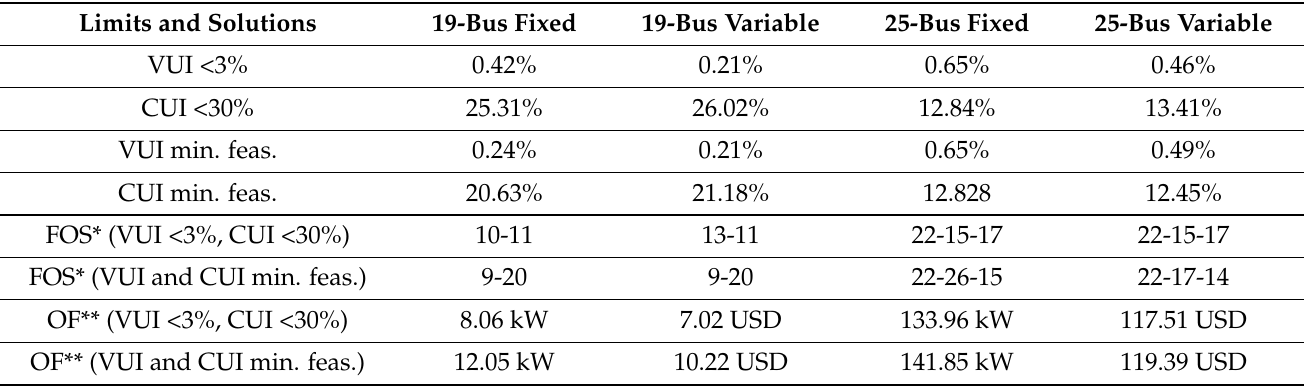
Table 16. VUI and CUI for unbalanced